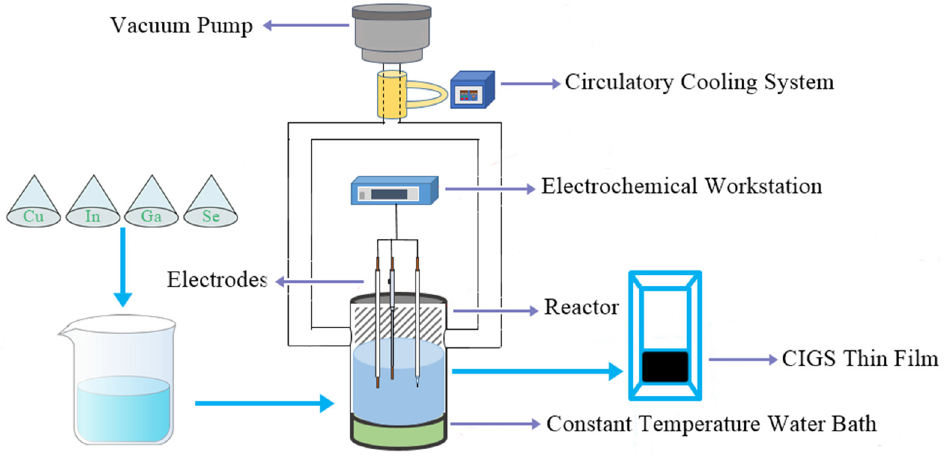
Figure 1. A schematic of the electrodeposition CIGS thin films